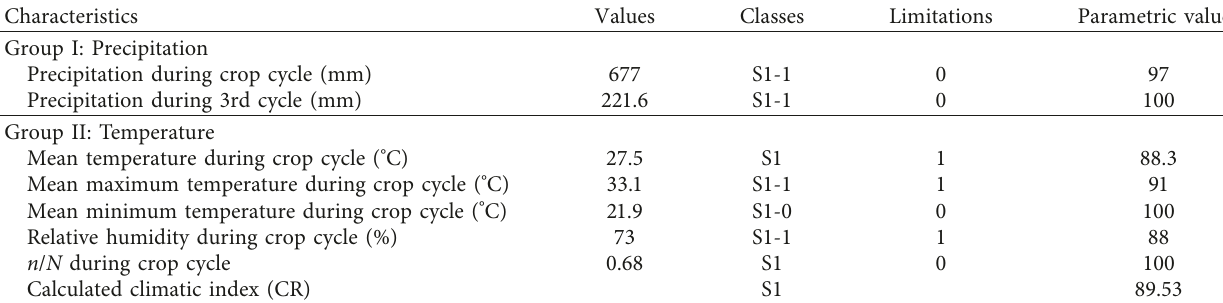
Table 4: Climatic suitability evaluation for the production of Sorghum